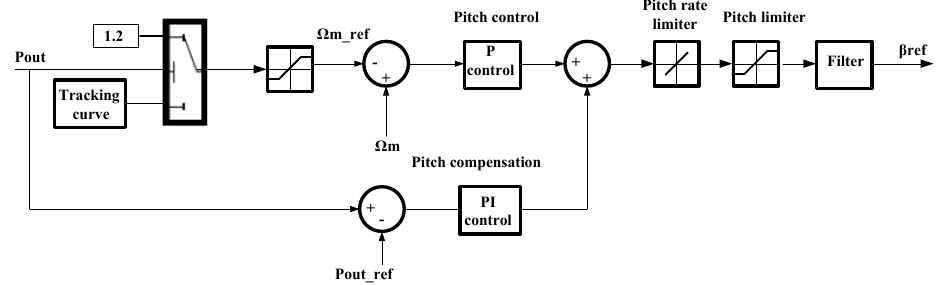
Figure 3. The traditional pitch angle control.